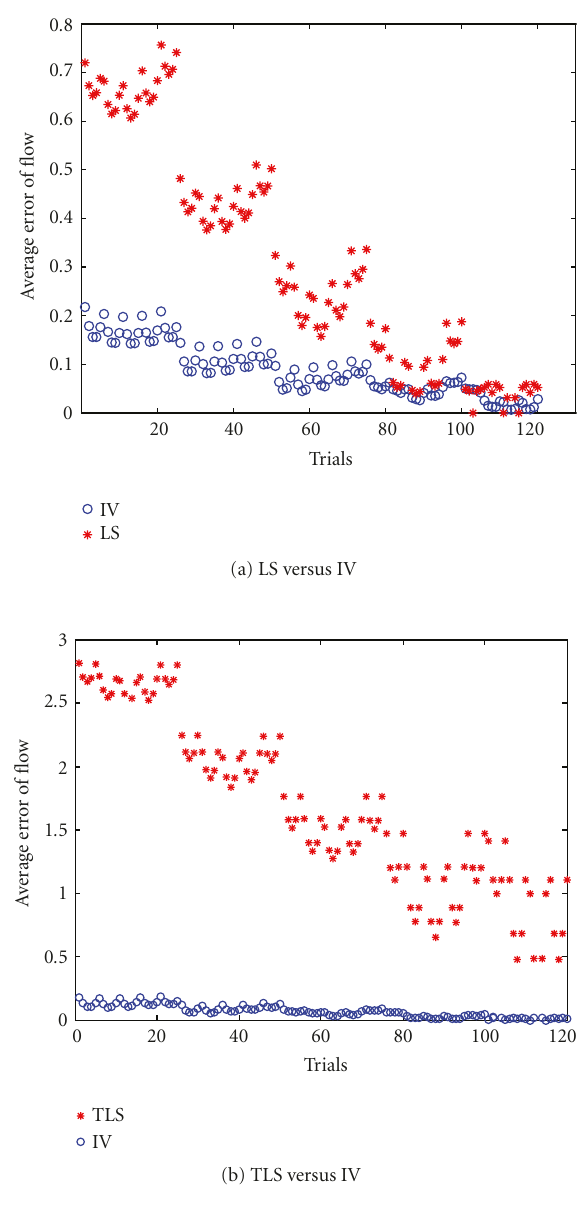
Figure 3: Performance comparison on the “cloud”